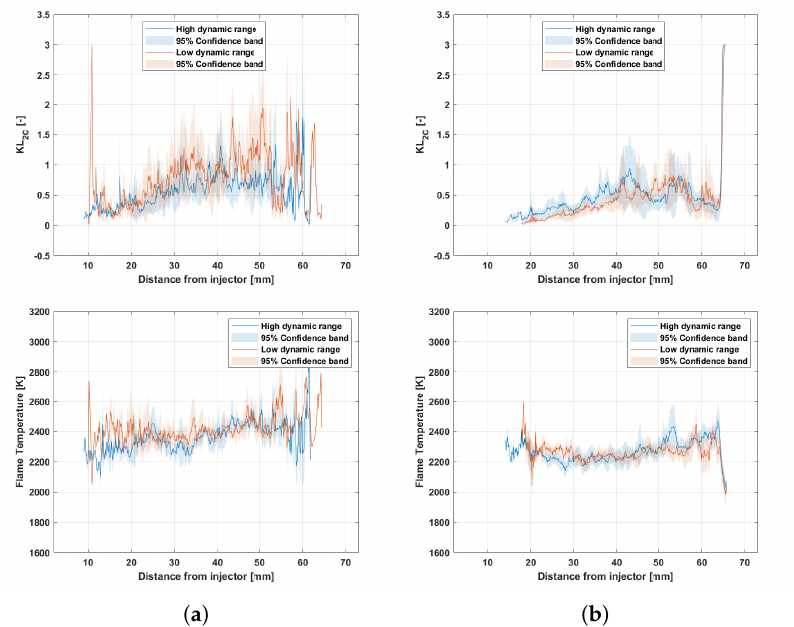
Figure 11. Comparison of high and low dynamic range for KL 2 C and temperature. t = 2900 µ